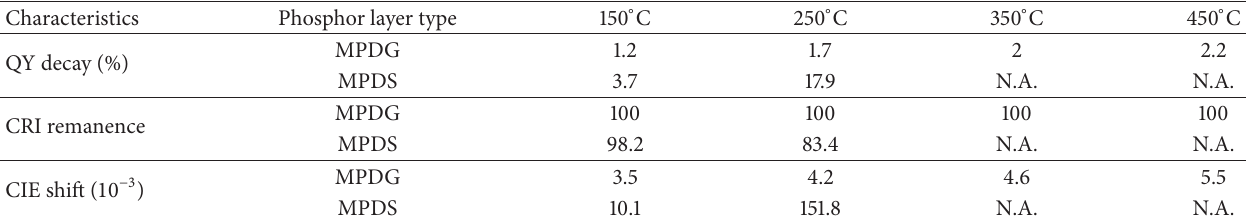
Table 3: Characteristics of MPDG and MPDS based WLED samples accelerated thermal aging after 1008